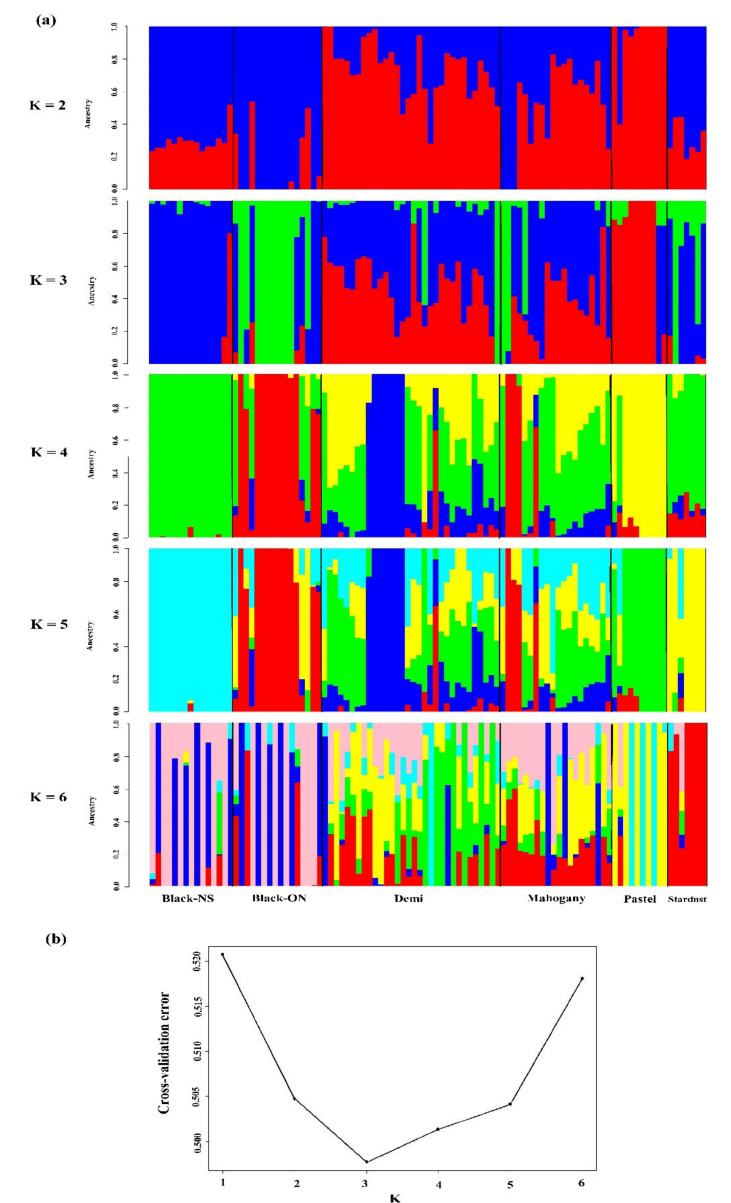
Figure 2. Admixture patterns of American mink color-types: ( a ) Admixture analysis at K = 2 to K = 6 in five color-types of American mink. Each individual was represented by a vertical bar and different colors were used to present color-types; ( b ) Cross-validation error as a function of K for admixture analysis of five color-types. The lowest cross-validation error was found at K = 3. Black-NS and Black-ON represent the black color-type samples collected from the Canadian Center for Fur Animal Research (Truro, NS, Canada) and Millbank Fur Farm (Rockwood, ON, Canada),